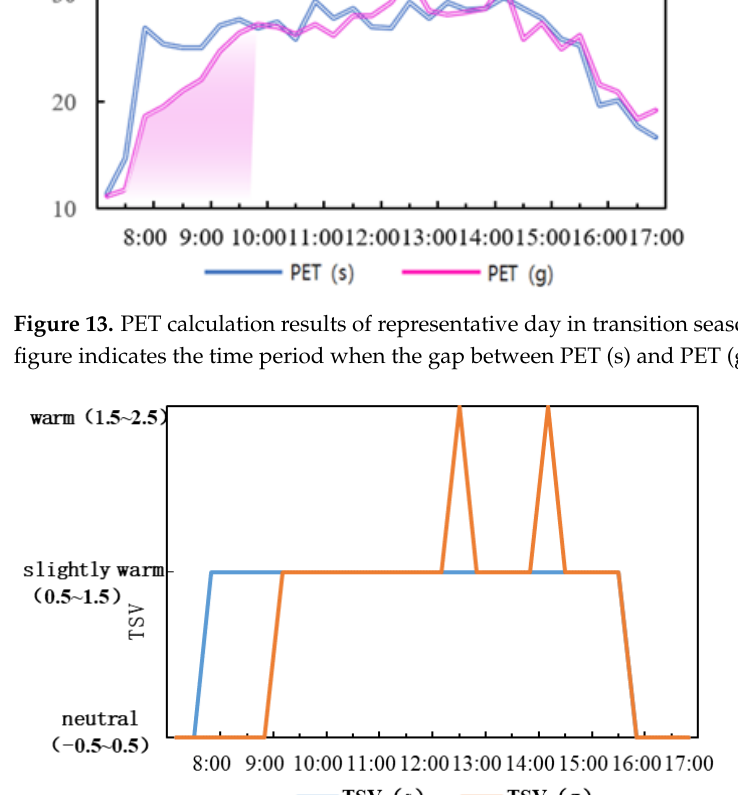
Figure 15. PET calculation results of representative day in winter. The thermal sensation data correspond to Figure 16 and show that the TSV (s) and TSV (g) are different at some moments. According to the results of TSV (s), people feel slightly cool in the morning, and as time goes on, the heat sensation will fluctuate between slightly cool and moderate. However, the TSV (g) is moderate from 11 o′clock to 15 o′clock, and the results are overestimated. This means that, in the winter, the TSV results based on the results of the globe-thermometer method will overestimate people′s thermal sensation during some times in the afternoon.